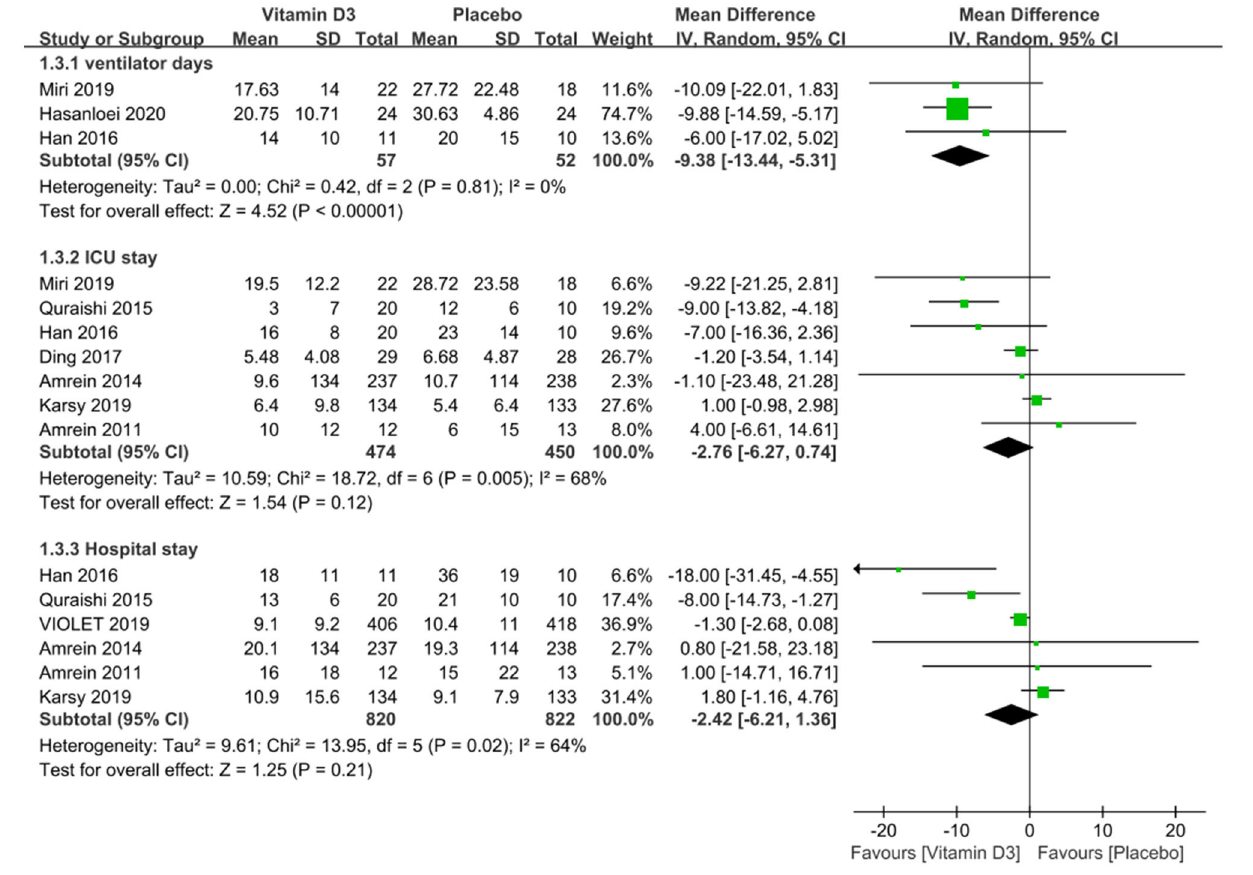
were proven to be highly prevalent in critical illness (34,